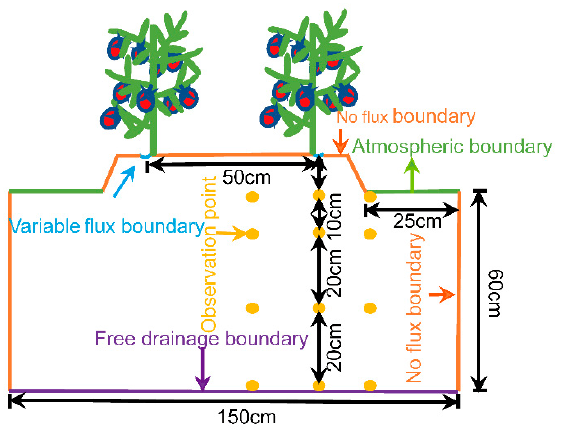
Figure 2. Arrangement of observation points and setting of boundary conditions in HYDRUS-2D.